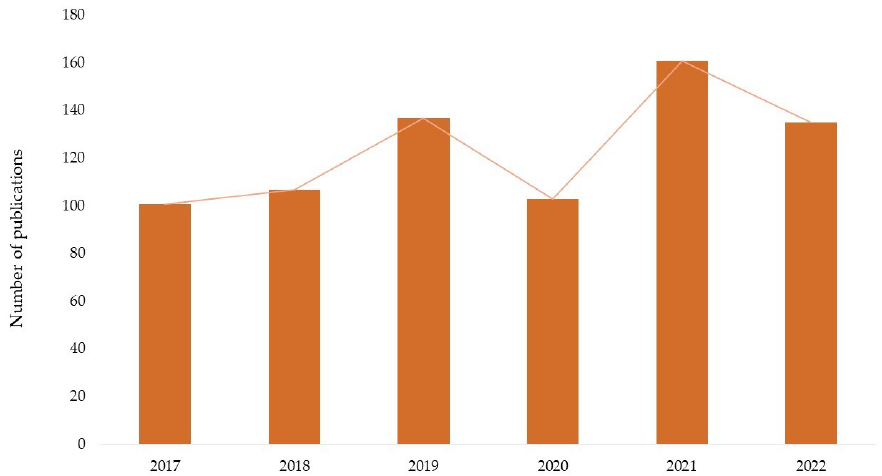
Figure 4. Trend in the annual number of studies published,